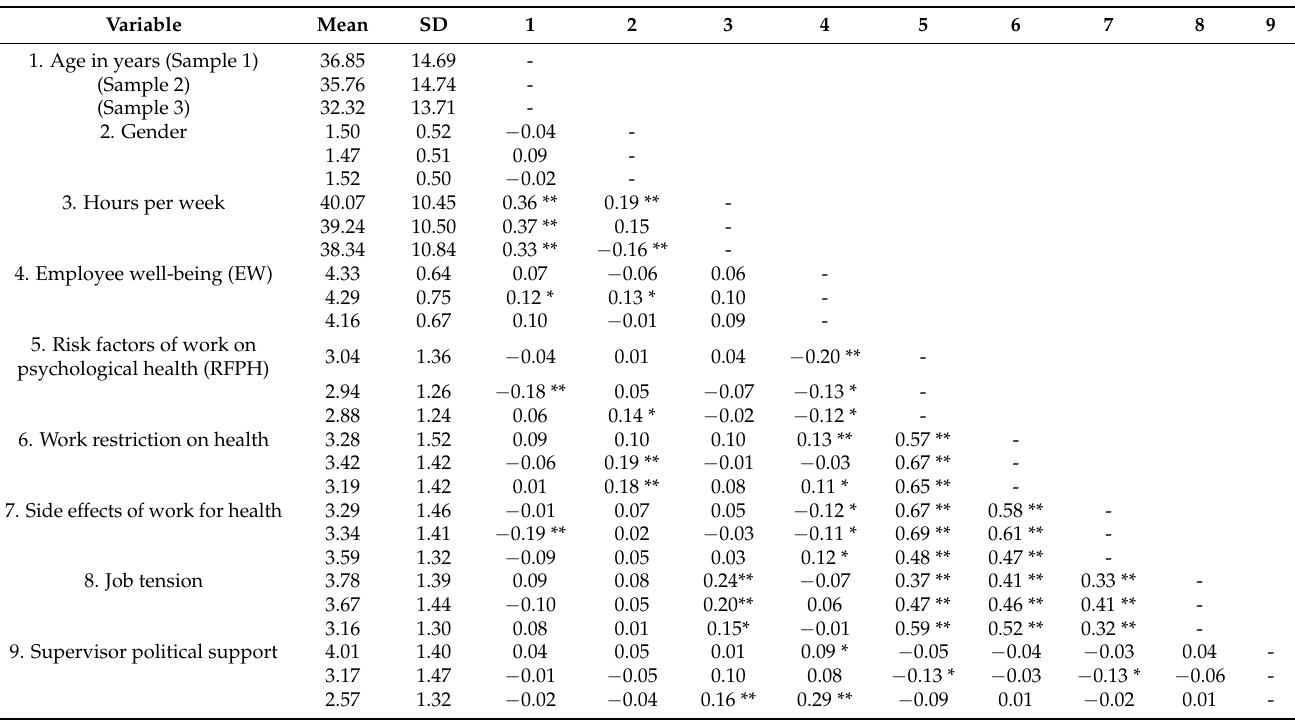
Table 1. Descriptive statistics and correlations of in-study